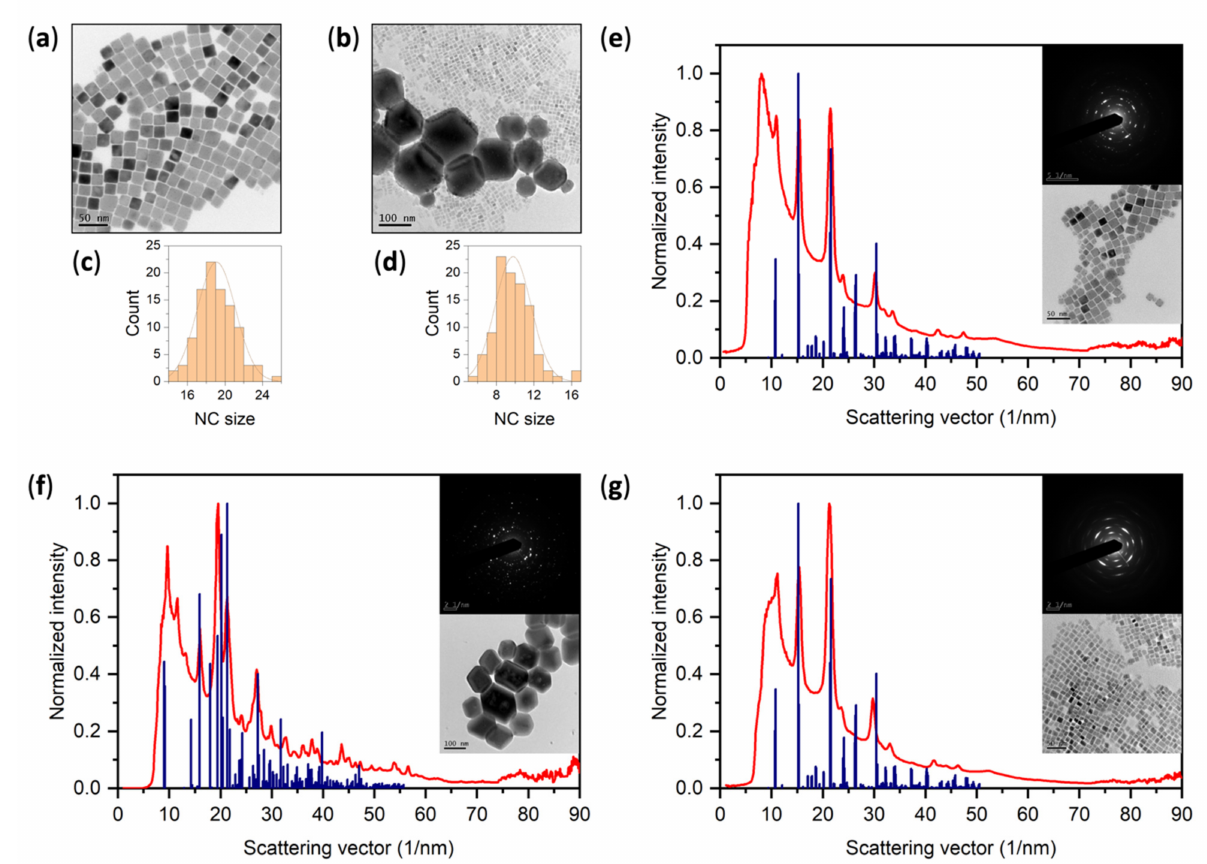
Figure 2. ( a ) TEM micrograph of the pure sample; ( b ) TEM micrograph of the mixed sample; ( c ) size distribution of 100 crystals presented in ( a ), the mean size is (19.1 ± 0.2) nm; ( d ) size distribution of 100 crystals presented in ( b ), the mean size is (9.8 ± 0.2) nm; ( e ) integrated radial intensity profile from a SAED pattern (in the inset) of the pure sample (corresponding micrograph in the inset) compared to the ICDD PDF-2 record for CsPbBr 3 #01-072-7929; ( f ) integrated radial intensity profile from a SAED pattern (in the inset) of large hexagonal crystals present in the mixed sample (corresponding micrograph in the inset) compared to the ICDD PDF-2 record for Cs 4 PbBr 6 #01-077-8224; and ( g ) integrated radial intensity profile from a SAED pattern (in the inset) of small cubic crystals present in the mixed sample (corresponding micrograph in the inset) compared to the ICDD PDF-2 record for CsPbBr 3 #01-072-7929. Sizes of nanocrystals were measured using an ImageJ software [51] and SAED patterns were integrated using the ProcessDiffraction software